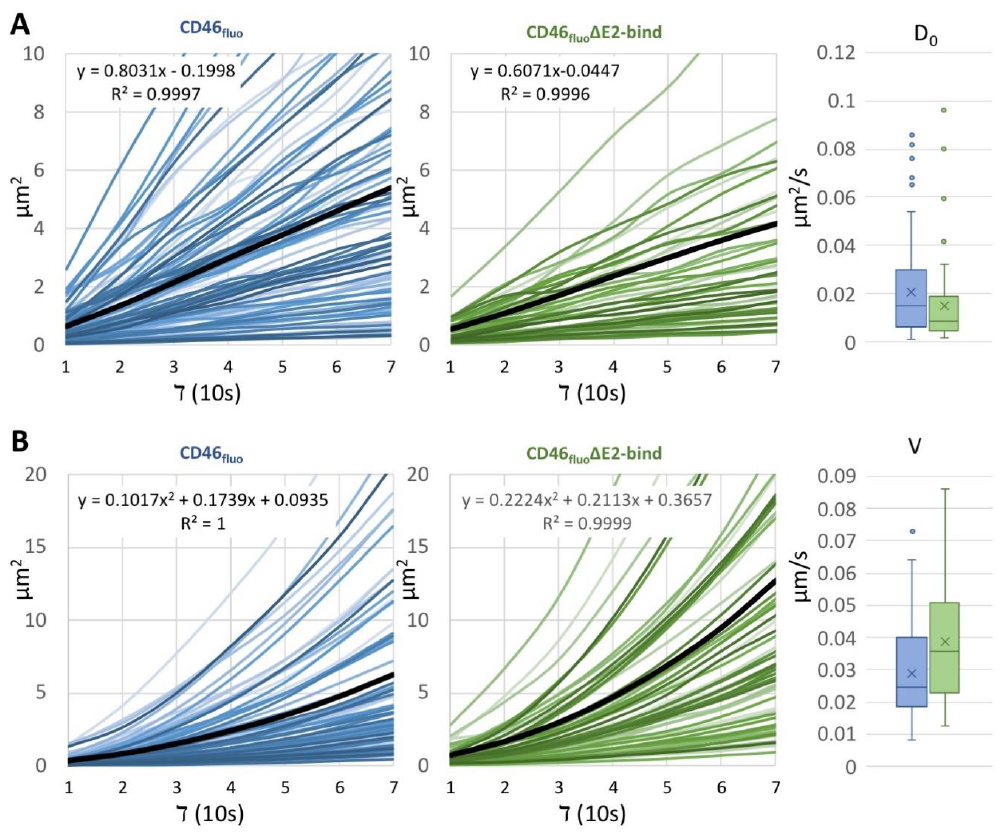
Figure 5. The average velocity of directed motion of BVDV E2-mCherry particles is increased on the surface of SK6 CD46 fluo ∆E2bind cells. MSD analysis of particle movement on SK6 CD46 fluo and CD46 fluo ∆E2bind cells. ( A ) Slopes of tracks on SK6 CD46 fluo (blue) and CD46 fluo ∆E2bind (green) cells displaying a linear increase and distribution of the calculated diffusion coefficient D 0 depicted as box and whisker blot. The mean is indicated by x and outliers (Q3 + 1.5 times interquartile range) are depicted as dots. Average slopes are depicted as thick black lines. ( B ) Slopes of tracks on SK6 CD46 fluo (blue) and CD46 fluo ∆E2bind (green) cells displaying an exponential increase and distribution of the calculated particle velocities V, depicted as box and whisker blot. The mean is indicated by x and outliers (Q3 + 1.5 times interquartile range) are depicted as dots. Average slopes are depicted as thick black lines.